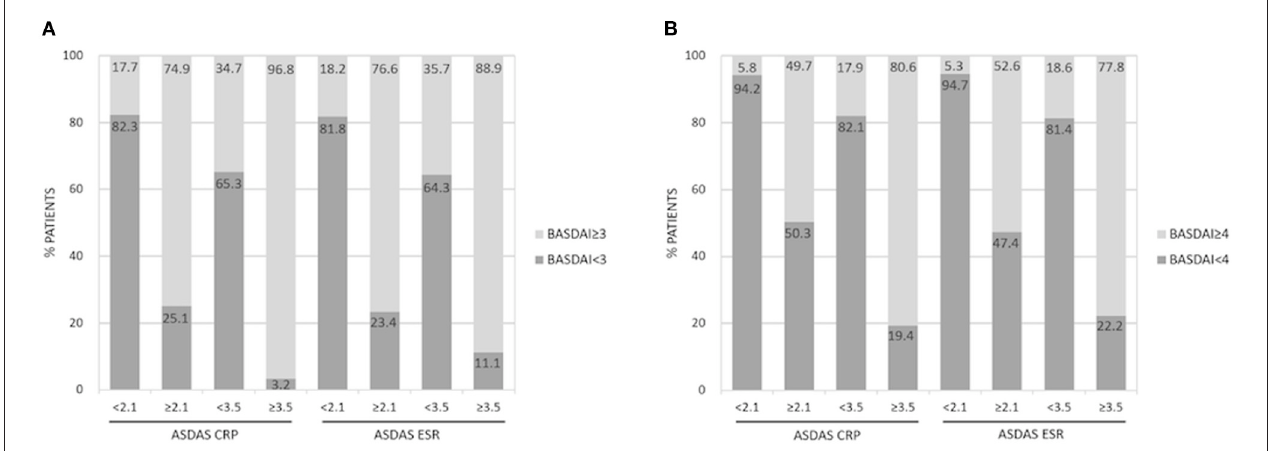
FIGURE 1 | Agreement between high and very high disease activity states according to ASDAS-CRP/ASDAS-ESR and BASDAI ≥ 3 (A) and BASDAI ≥ 4 (B) .